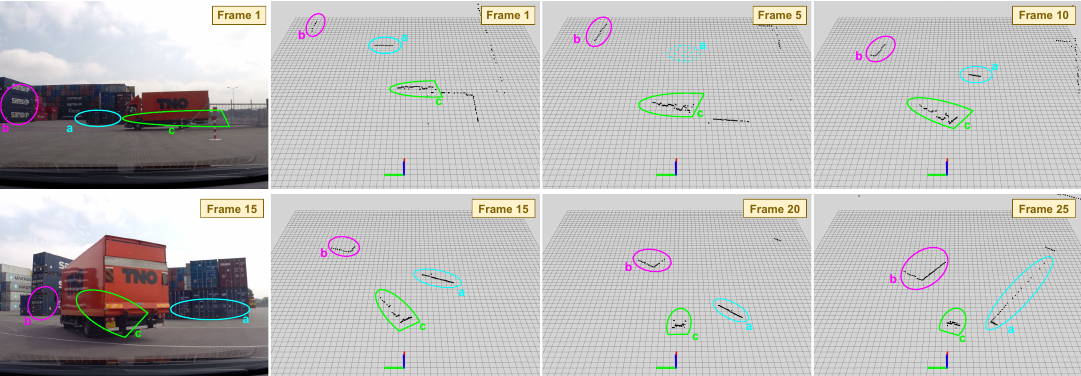
Figure 2. 2D-LRFs mounted on mobile platforms provide scarce measurements that are sometimes hard to interpret even for the human eye. We show several frames of a SICK LRF in a port environment performing the vehicle following task. It can be appreciated how detected objects a and b vary drastically in size and shape due to occlusions and perspective changes. In the same manner the moving truck c has a completely different shape comparing frame 1 to frame 15. Best viewed in